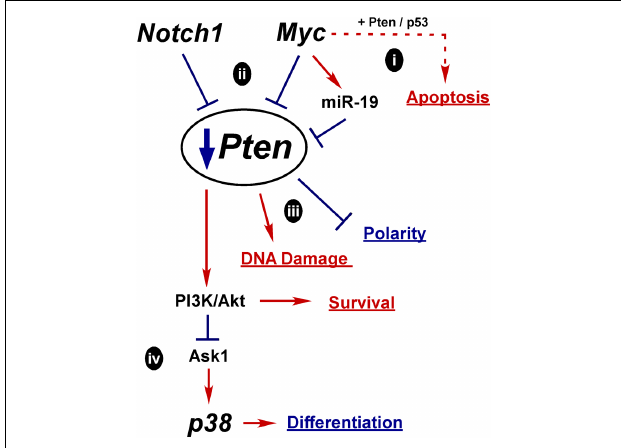
FIGURE 5 | Hypothetical mechanisms for Pten down regulation in prostate oncogenesis . Myc or Notch1 could each act to suppress Pten expression early in oncogenesis. Loss of Pten may be a prerequisite for Myc upregulation to relieve Myc induced apoptosis (i) . However, moderate activation of Myc could also contribute to Pten downregulation, via either transcriptional repression or induction of miR-19. Increased Notch1 signaling may also transcriptionally downregulate Pten (ii) . Ultimely downregulation of Pten can lead to more DNA damage, loss of polarity, and increased PI3K/Akt survival signaling (iii) . Loss of Pten can lead to stimulation of p38 via activation of upstream MAPKs, such as Ask1, further contributing to oncogenesis (iv)